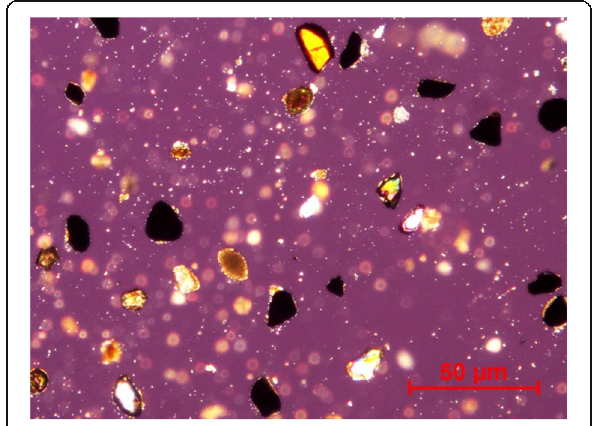
Fig. 8 Heavy fraction composed of opaque ’ s (isotropic), zircon (exhibits zoning and green, yellow, or upper part), heavy fraction, C.N. × 40